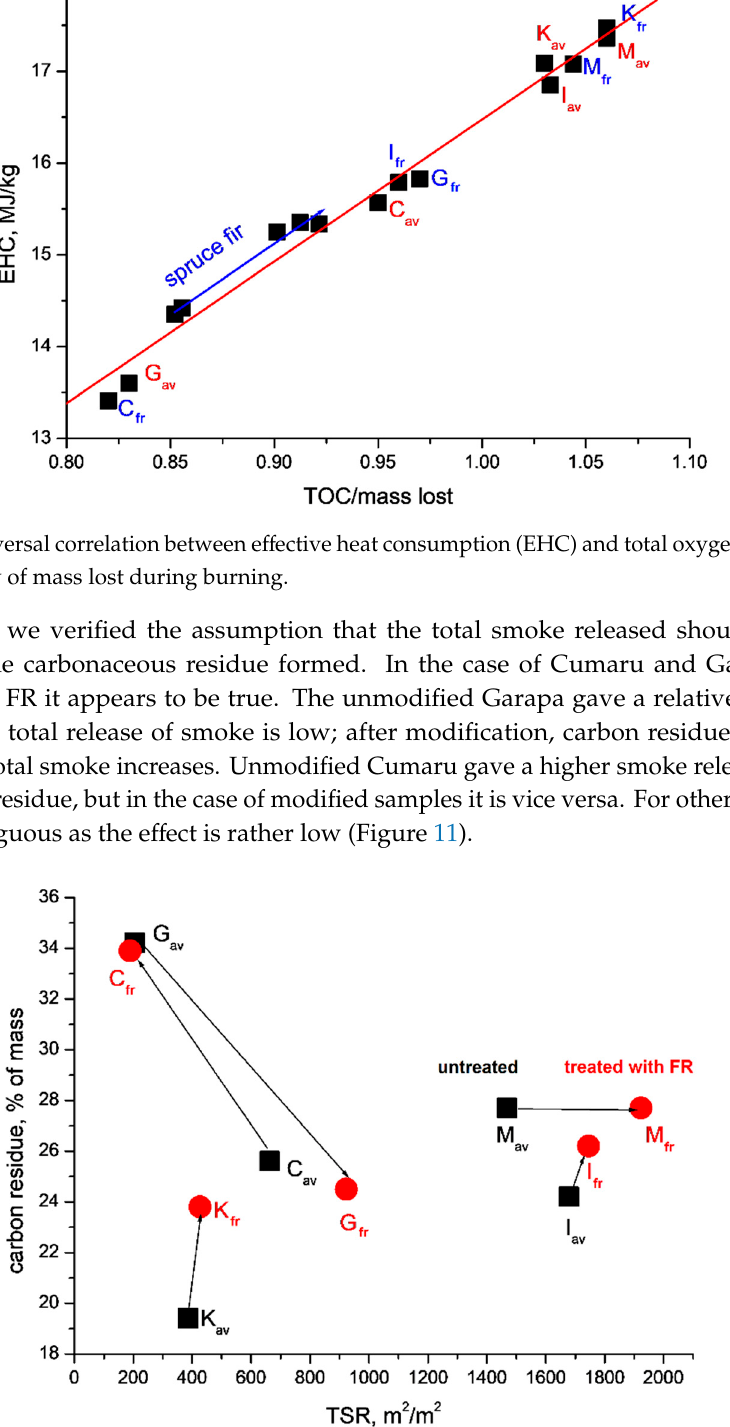
Figure 9. The correlation between MARHE and total oxygen consumed for untreated and treated samples of tropical woods (Table 2). The cone radiancy is 35 kW/m 2 .